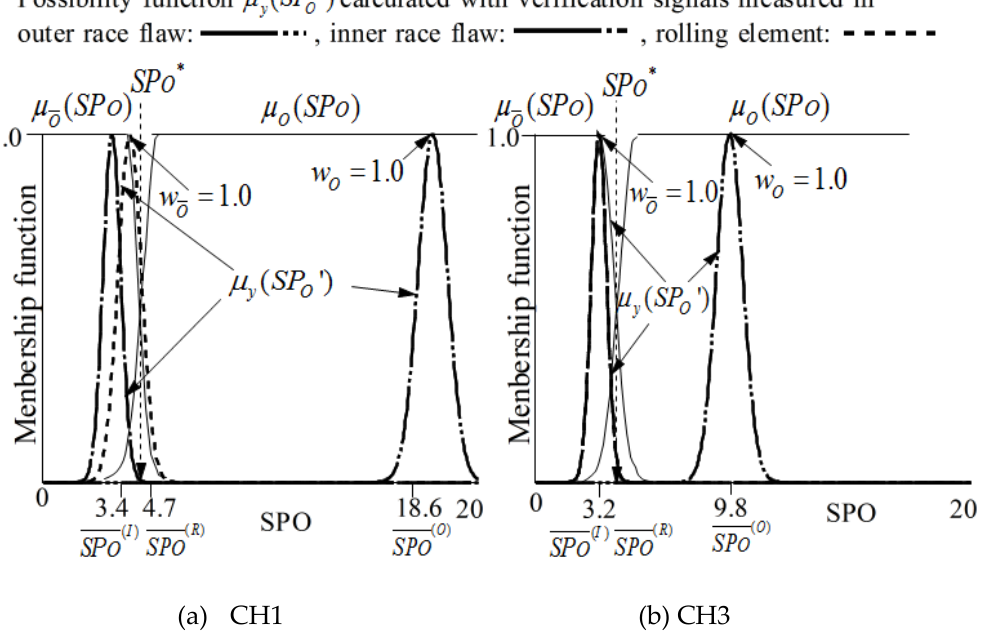
Figure 10. 𝜇 O (𝑆𝑃 𝑂 ) , 𝜇 O̅ (𝑆𝑃 𝑂 ) , and 𝜇 𝑦 ( SP O ’ ) for the judgement of outer race flaw. Figure 10. µ